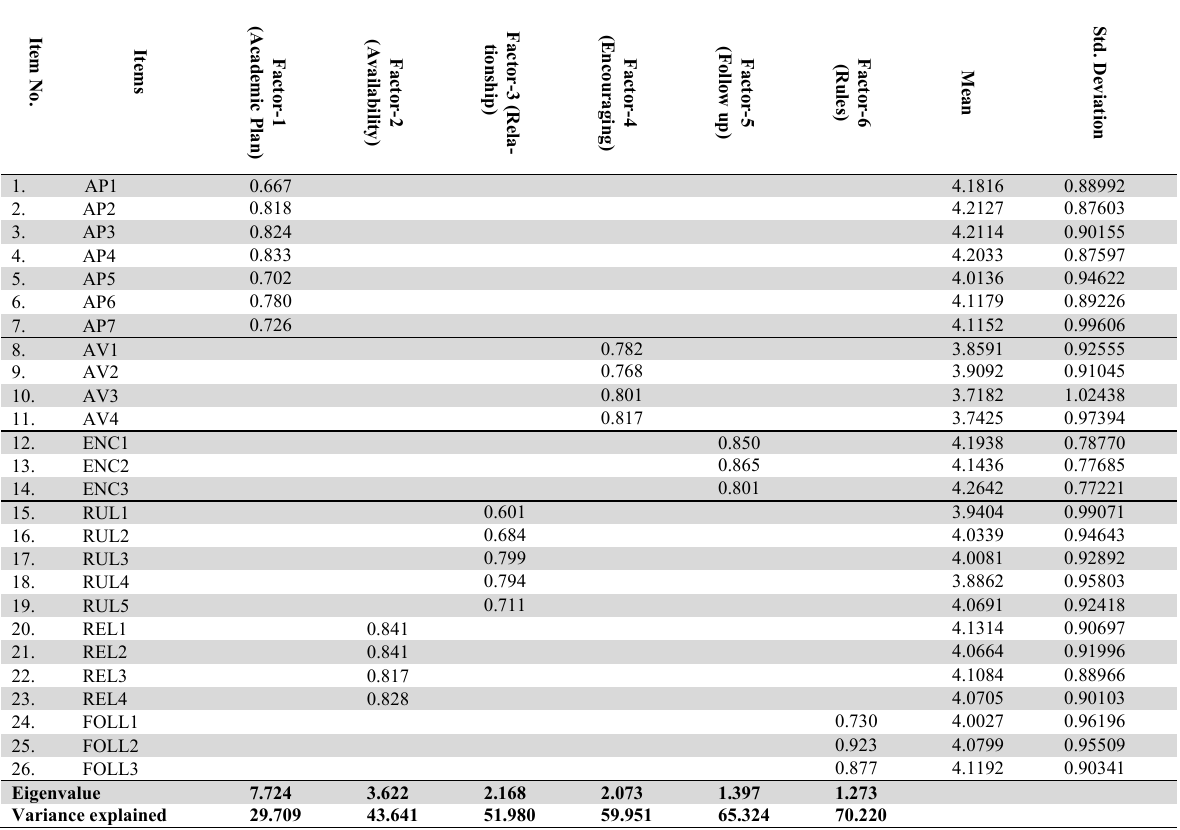
The Result of Principle Component